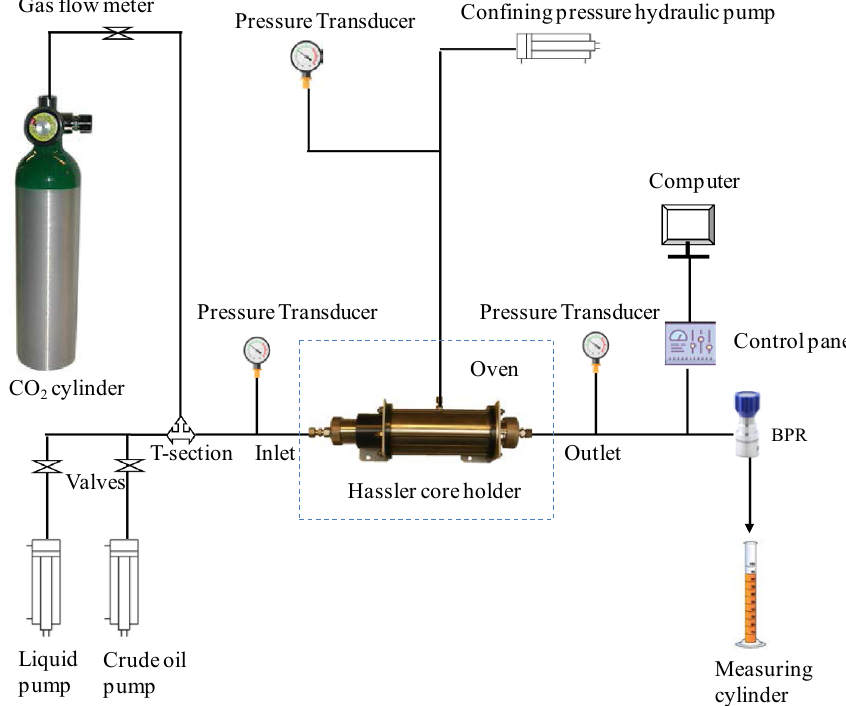
Fig. 1 Schematic of the core flooding system